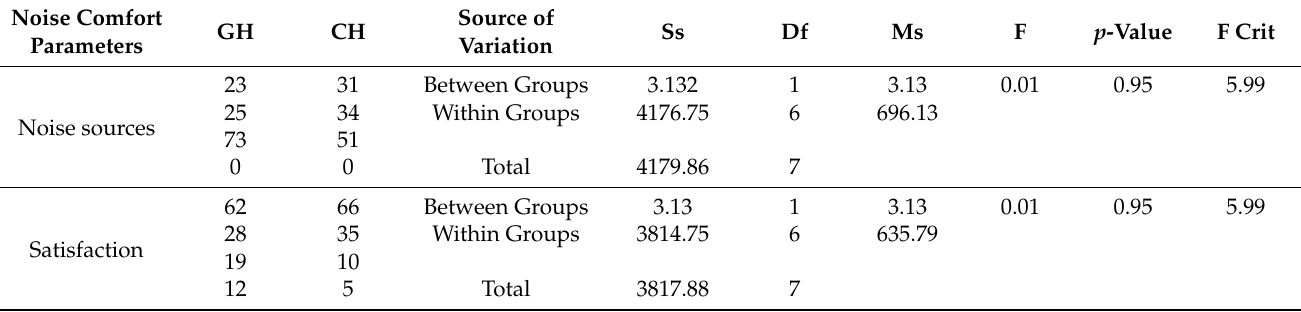
Table 3. ANOVA evaluation of the noise comfort parameters in both